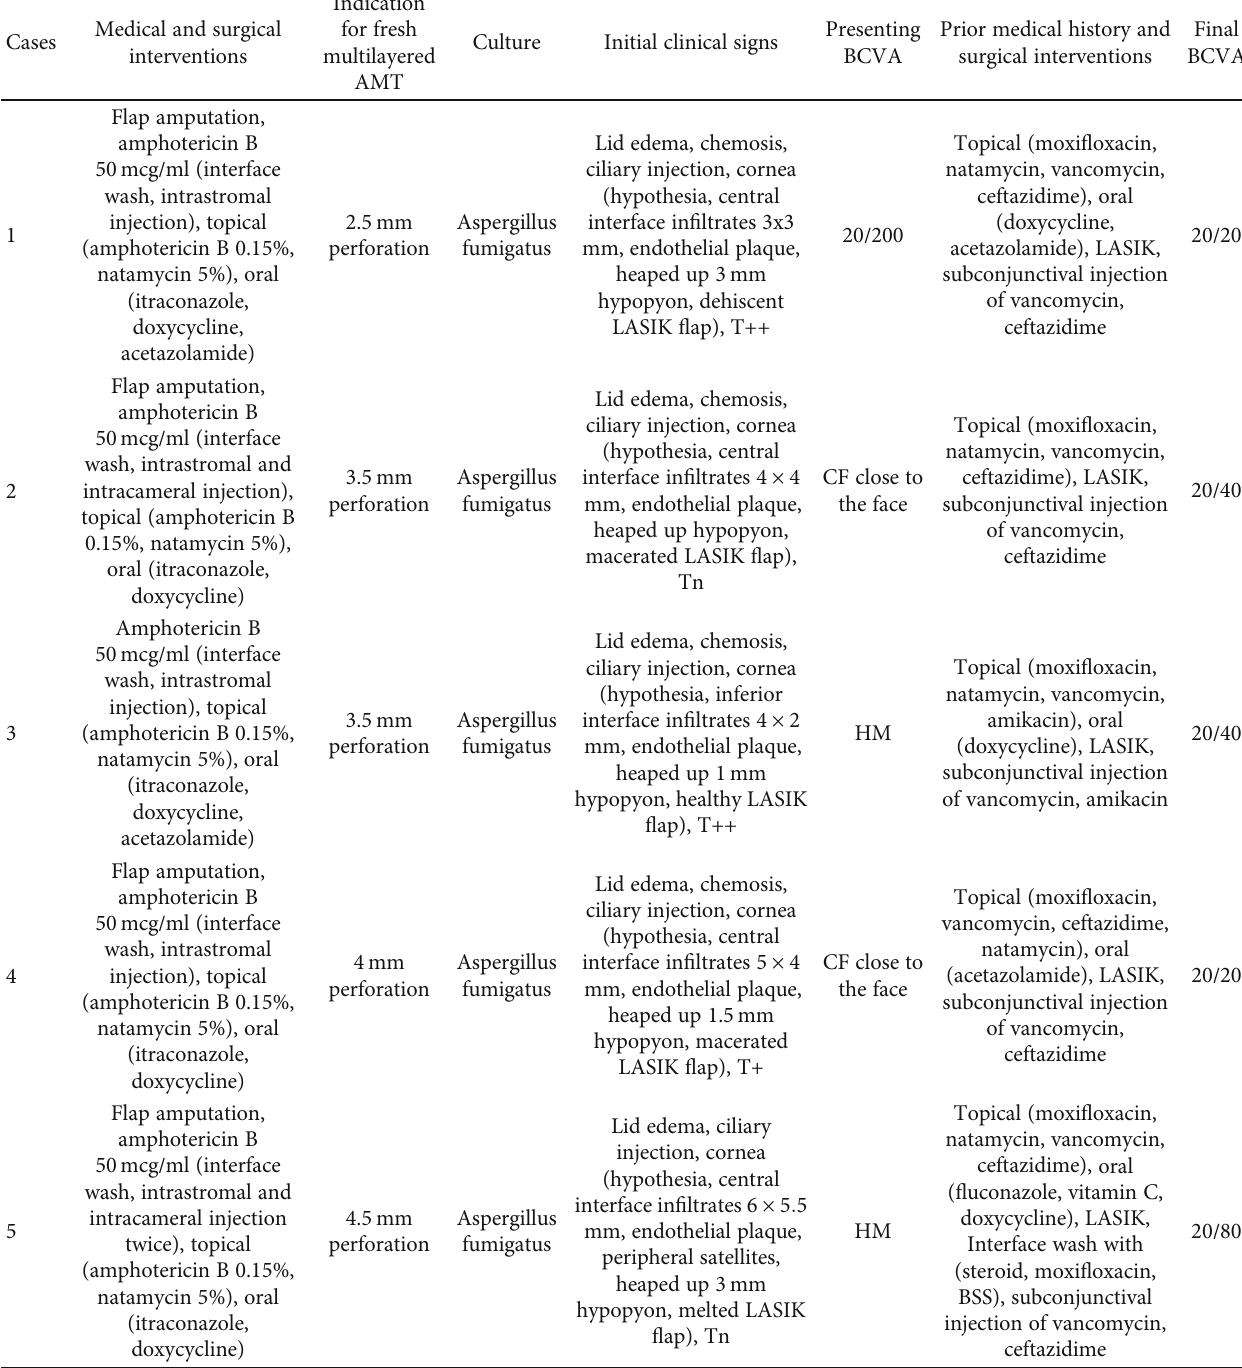
Table 2: Clinical and microbiological features of